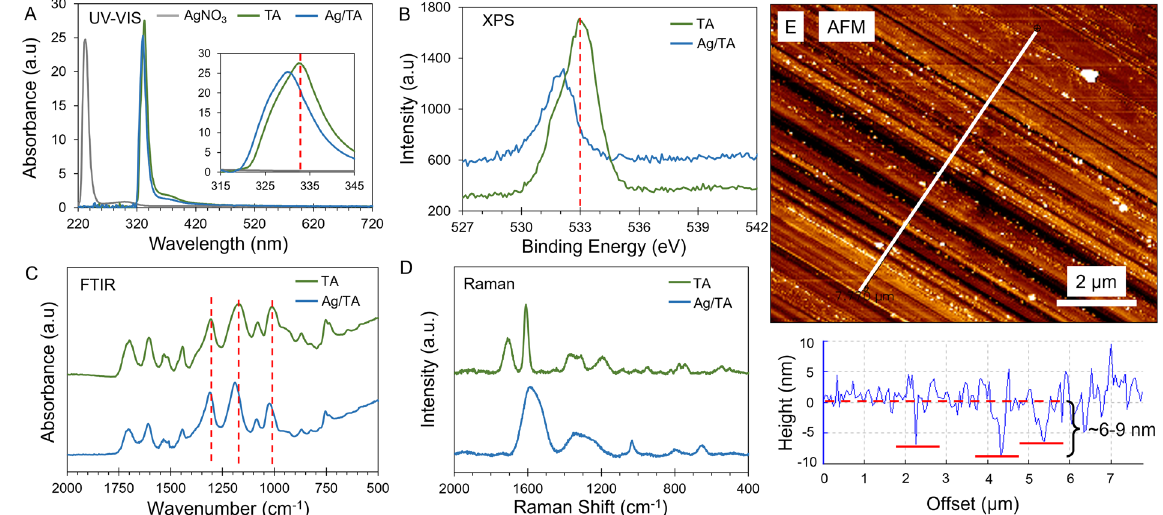
Figure 1. Ag/TA complexes and coatings. ( A ) UV–VIS spectra of aqueous solutions of AgNO 3 , TA, and Ag/TA complexes. XPS ( B ), FTIR ( C ), and Raman ( D ) spectra of TA and Ag/TA complexes. ( E ) AFM image and height profile of a scratched Ag/TA coating on silicon deposited in ~ 10 s. The red dotted lines in ( B ) and ( C ) represent peaks of TA where shifts are seen for Ag/TA. The red dotted line in ( E ) represents the average height of the film, with the solid red lines signifying the underlying silicon wafer after